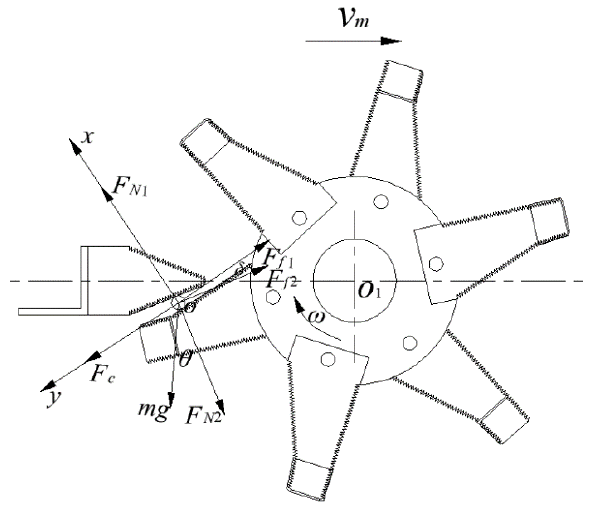
Fig. 9. Schematic diagram of moving and fixed cutter cutting